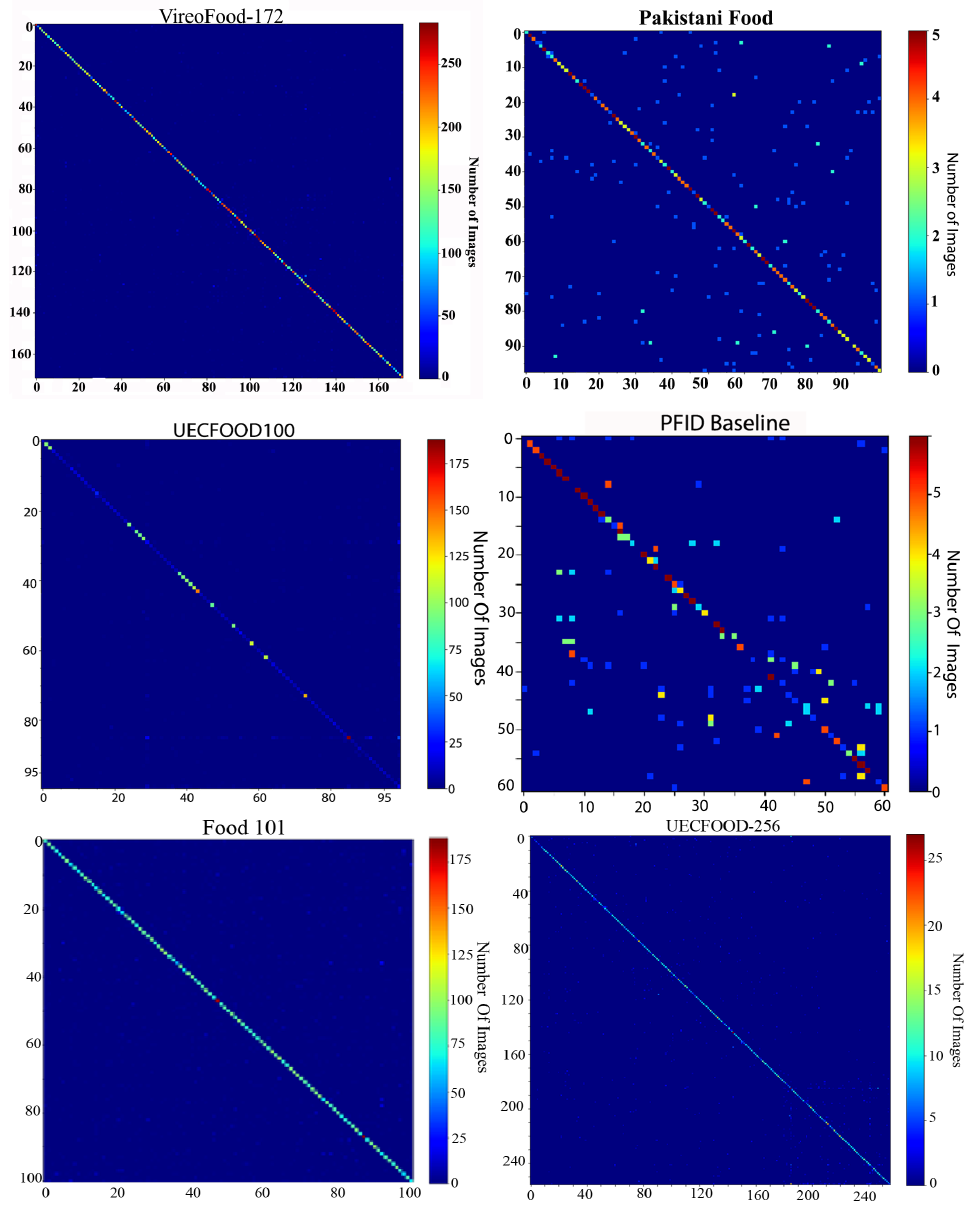
Figure 19. Comparison of each food category via the confusion matrix (x-axis and y-axis represent the number of classes) on the final PKELM model trained using the incremental learning protocol for all datasets (Best viewed under